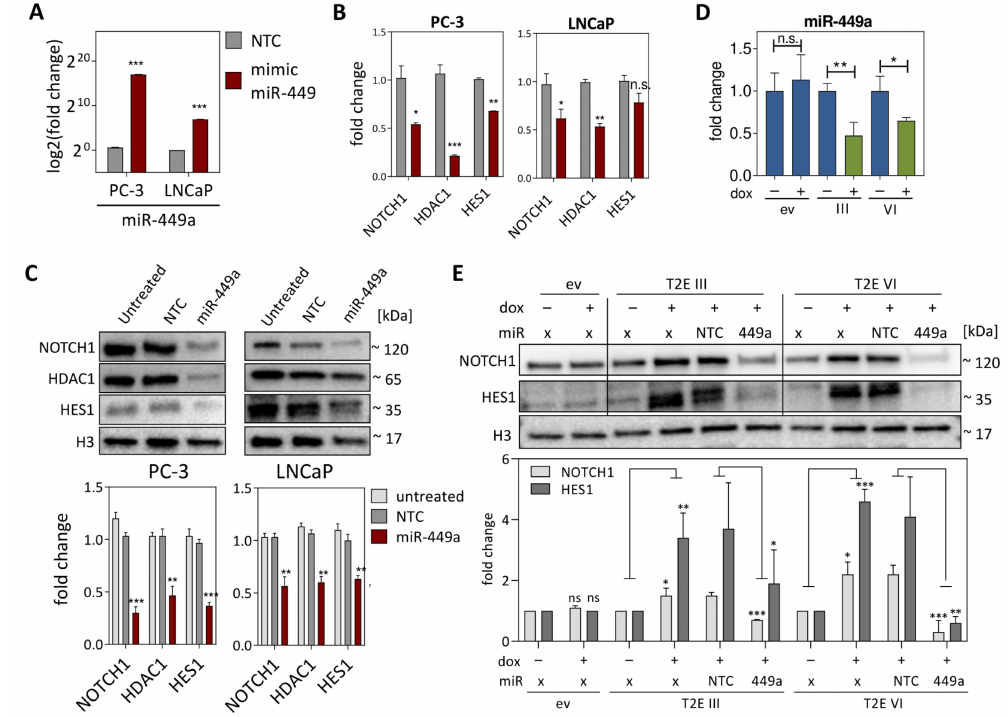
Figure 3. Gene regulation by miR-449a in PCa cell lines. ( A ) Quantitation of miR-449a mimic levels after transfection into PC-3 and LNCaP cells. ( B , C ) mRNA and protein levels of NOTCH1, HDAC1 and HES1 in PC-3 and LNCaP cells 72 h after miR-449a mimic transfection compared to non-target control (NTC). Histone H3 served as internal control. ( D ) miR-449a expression in LNCaP T2E cells without (blue) and with (green) induction of ERG with doxycycline (+). PBS treatment ( − ) served as control. ( E ) Western blot and protein quantification of NOTCH1 and HES1 in LNCaP T2E ev, III and VI cells, respectively, transfected with no/control mimic/ miR-449a mimic (x/NTC/449a) for 48 h, followed by repeated miRNA mimic transfection without/with ( − /+) PBS/doxycycline treatment for 72 h (n.s. not significant, * p ≤ 0.05; ** p ≤ 0.01; *** p ≤